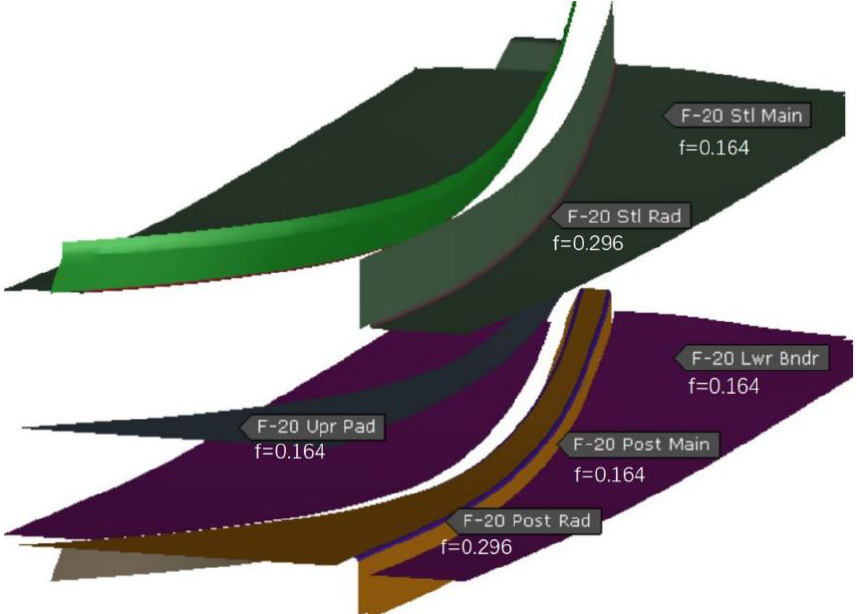
Figure 22. Die setup for stamping an automotive front load beam.